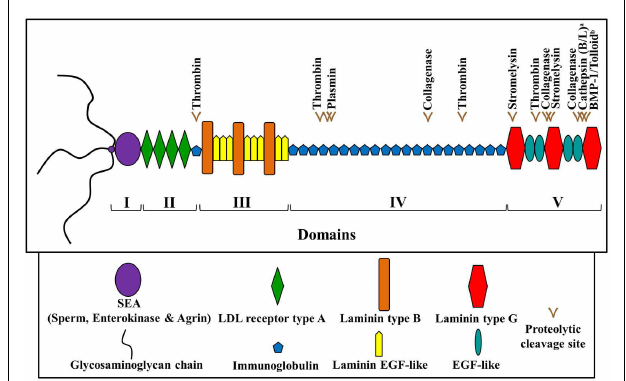
FIGURE 2 | Schematic diagram of human perlecan. Perlecan is made up of five domains and contains various predicted and experimentally determined proteolytic (proteases as labeled) cleavage sites. a Saini and Bix (2012); b Gonzalez et al. (2005). Adapted from Farach-Carson and Carson (2007) andWhitelock et al.